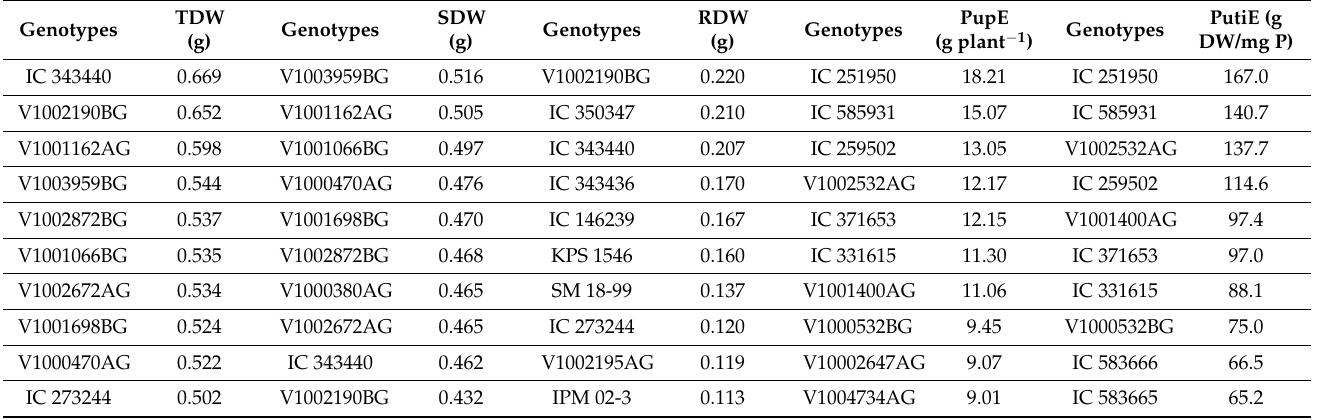
Table 4. Top 10 genotypes for traits contributing to PUE in 327 accessions of studied Vigna